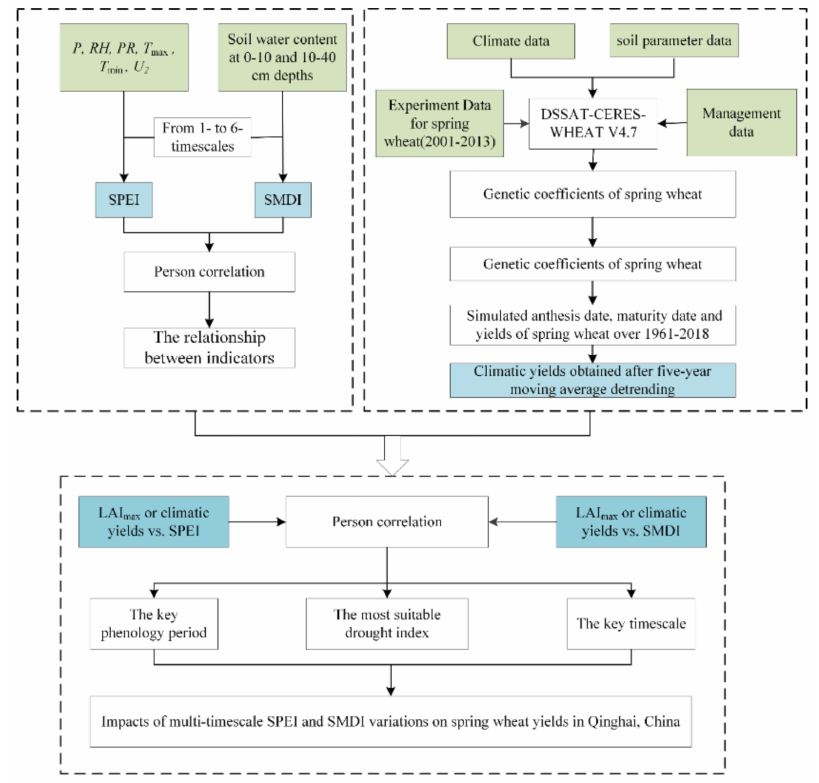
Figure 2. The overall technology roadmap of the